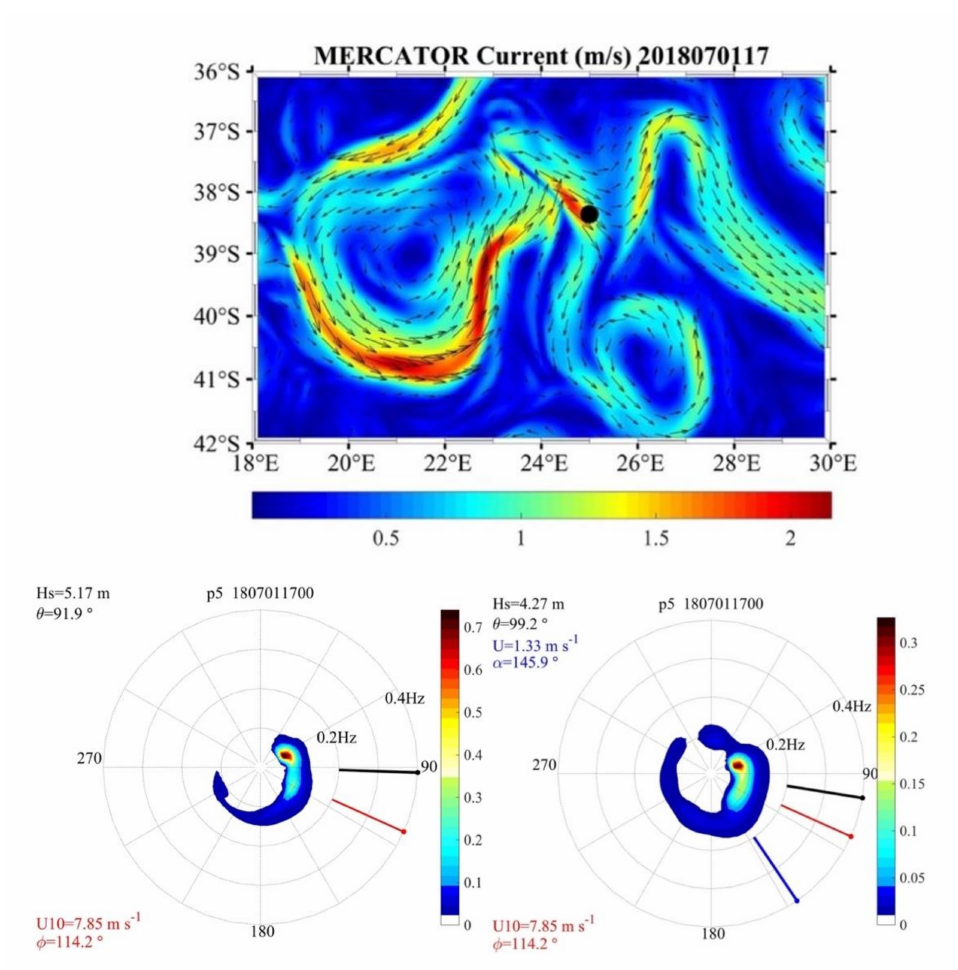
Figure 11. Zoom of the current field on the 1 July 2018 at 17 UTC and location P5 ( top ). SWAN wave spectra at P5 (25 ◦ E, 38.36 ◦ S) from the simulation considering only waves ( left ) and considering waves and currents ( right ). Symbols: ϕ (wind direction), θ (wave direction), α (current direction), U (Current velocity). The arrowhead (circle) points to where the waves and currents propagate (oceanographic